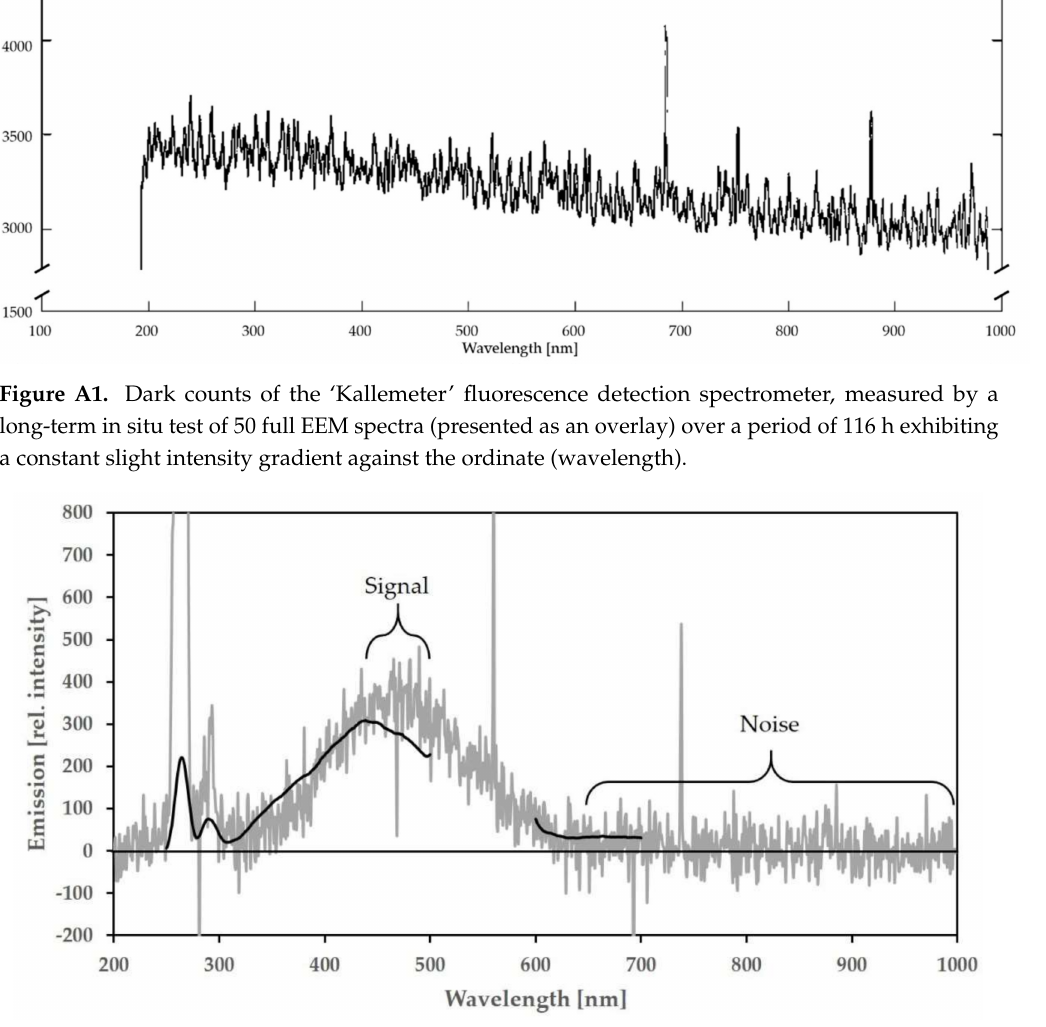
Figure A2. Signal to noise measurement of tap water with the ‘Kallemeter’ fluorescence detection spectrometer (grey line, integration time 300 s), and the LS55 laboratory spectrofluorometer (black line, 2nd maxima masked), both excitation wavelengths are 260 nm. Table A1. Comparison of different mirror combinations within the measuring cell. Shown: Mirror on (opposite) excitation and emission side, maximum value of the fluorescence signal, signal-to-noise ratio (S/N). Measured: Compound 610 from Starna Scientific Ltd. (Ilford, UK), flash lamp frequency: 100 Hz, excitation wavelength 440 nm, integration time: 5